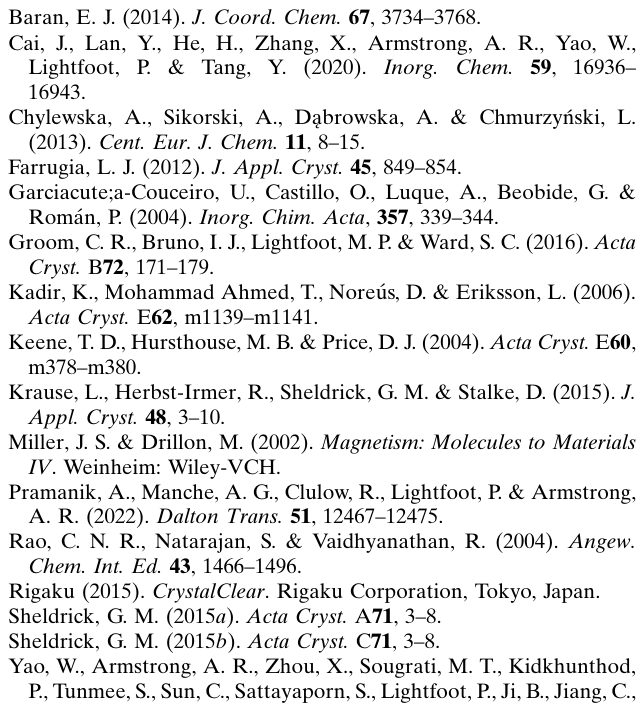
Crystal data Chemical